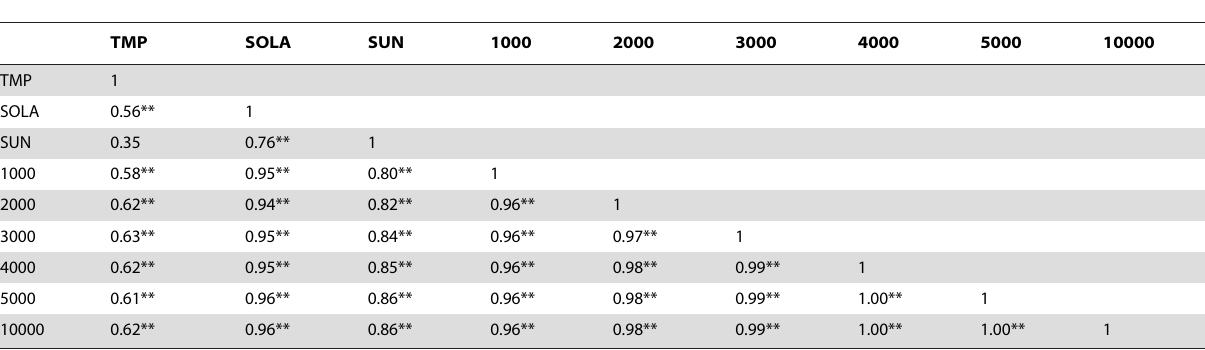
Table 3. Pearson correlation matrix of climatic variables.